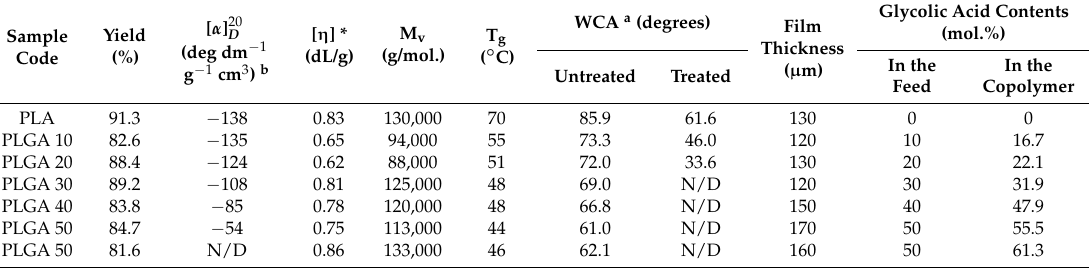
Table 2. Synthesis and results of PLA homopolymers and PLGA